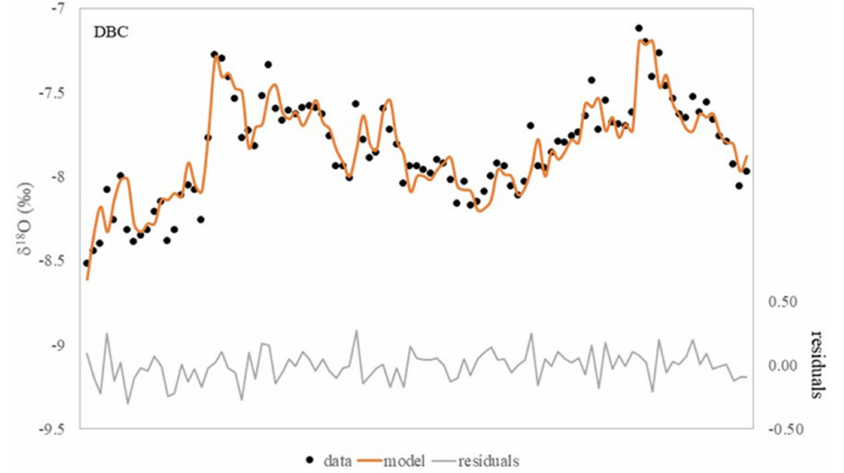
Figure 12. The agreement diagram between the observed DBC δ 18 O data and the data predicted by the MARS